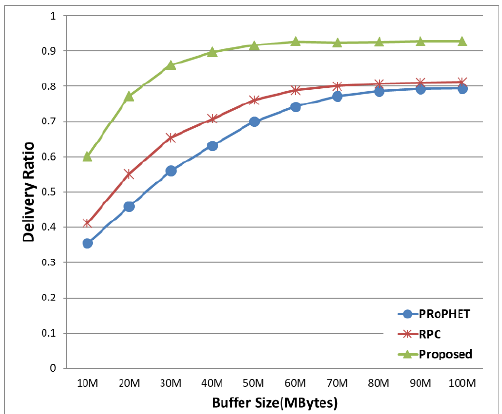
Figure 5. Delivery ratio for different buffer sizes.